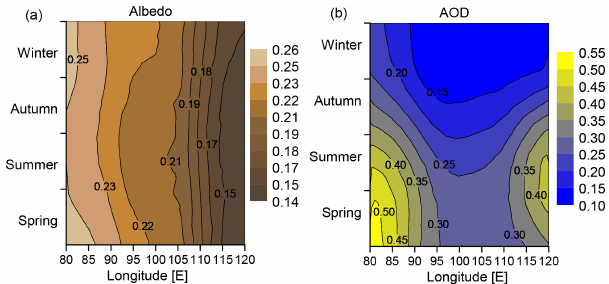
Figure 9. The temporal and spatial patterns of black sky shortwave broadband (300–3000nm) albedo (a) and AOD at 555nm (b)